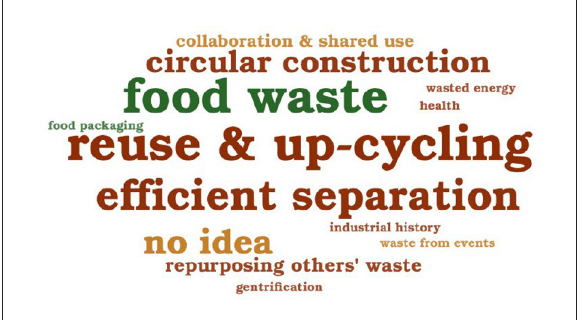
FIGURE2 Edited wordcloud made from the answers to the second survey question: What topics related to “waste” do you find most important in het Werkspoorkwartier